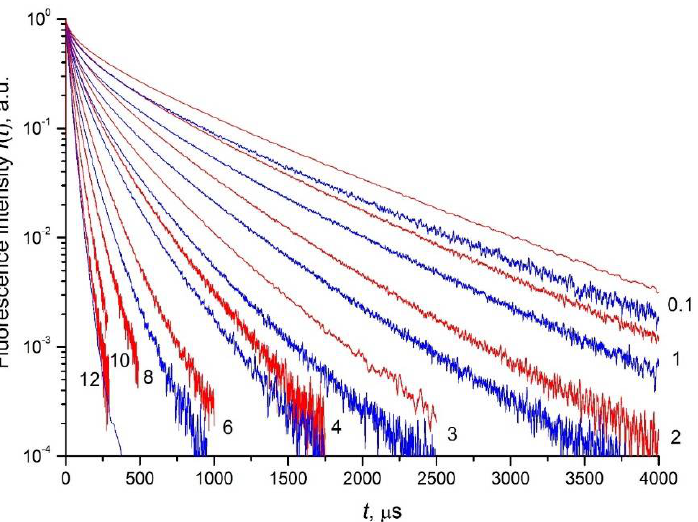
Figure 7. Luminescence decay kinetics of x at% Nd 3+ : LaF 3 ( x is indicated in the figure) detected at the 4 F 3/2 → 4 I 9/2 transition of the Nd 3+ ion at λ det = 862.8 nm wavelength upon laser excitation to the 4 G 5/2 level (λ exc = 577.8 nm) for NPs samples of type I (blue curves) and to the 4 F 5/2 + 2 H 9/2 level (λ exc = 789 nm) for NPs samples of type II (red curves).